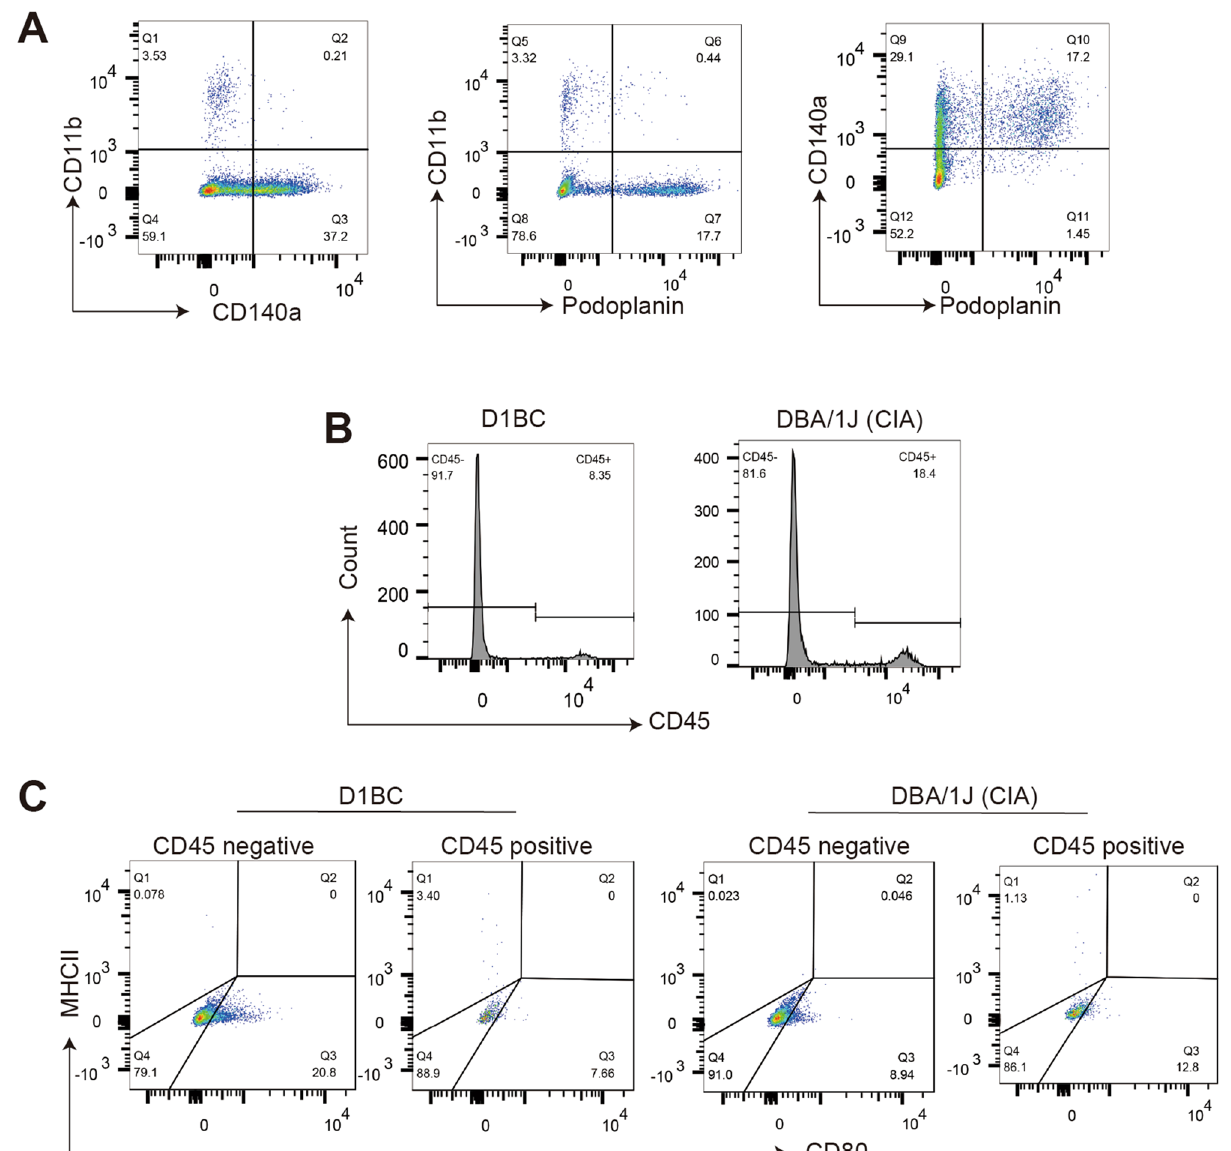
Figure 3. FLSs express more CD80 in D1BC mice. Synovial cells were obtained from D1BC and DBA/1 J mice (CIA) with inflammatory arthritis and cultured for one week. ( A ) Synovial cells were analyzed by flow cytometry using antibodies against CD11b, CD140a, and podoplanin. ( B ) Representative histograms of CD45 expression in D1BC and DBA/1 J mice. ( C ) MHC II and CD80 expression in CD45 + and CD45 − synovial cells. All the cells were gated as a 7-AAD-negative